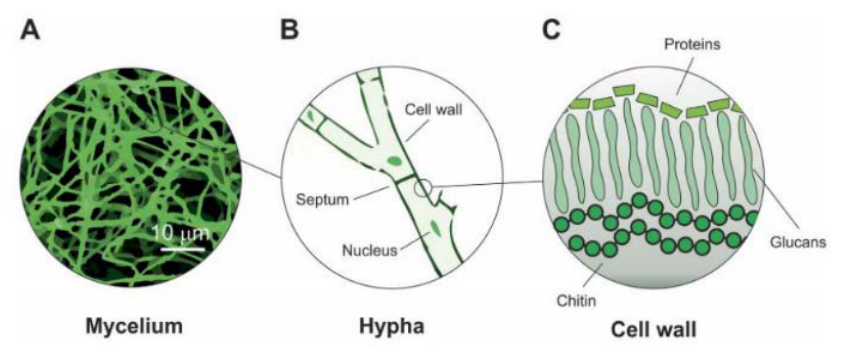
Figure 2 (A) Optical Morphology of Mycelium Fiber (B) Schematic Representation of Hyphae (C) Schematic Representation of The Cell Wall (Haneef Et Al.,